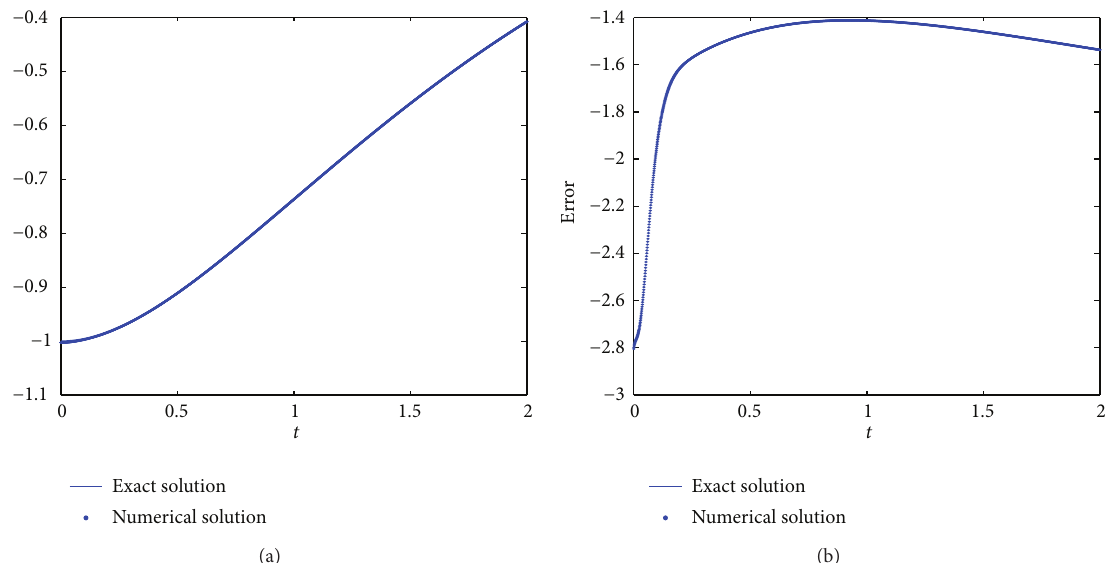
Figure 3: The exact solution 𝑓(𝑡) and the numerical solution of